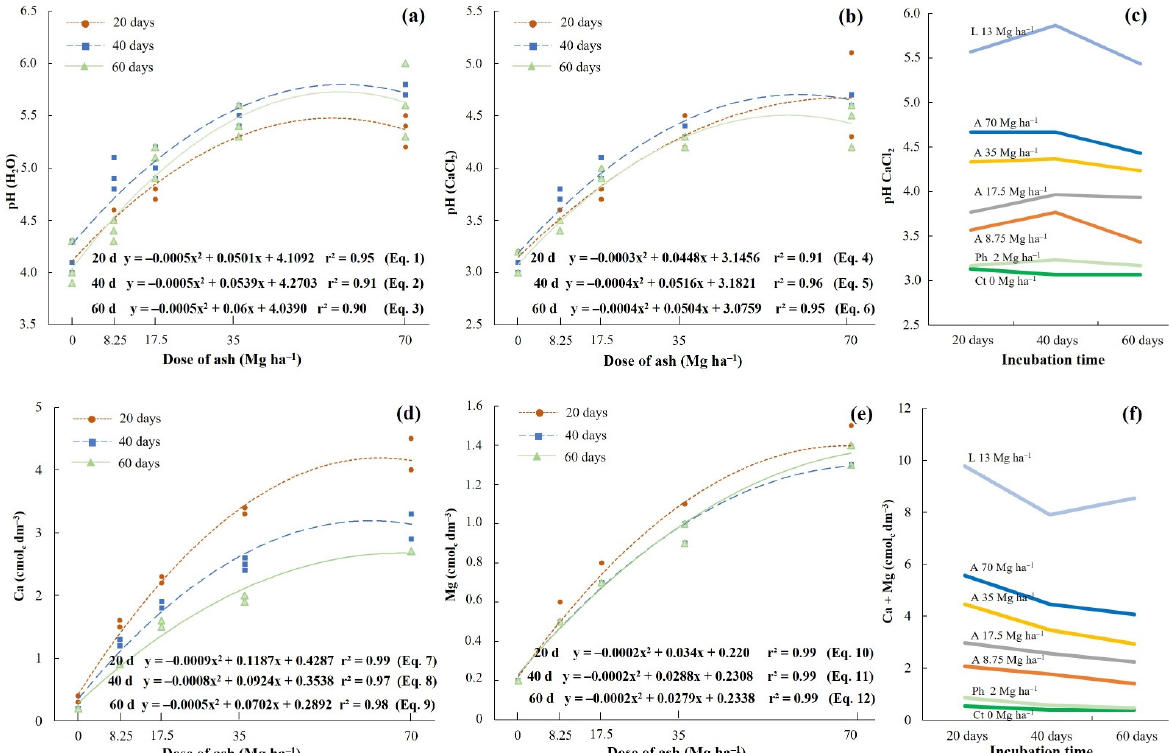
Figure 3. Chemical attributes of the Yellow Latosol after the three incubation times: pH in H 2 O ( a ), pH in CaCl 2 ( b ), and extractable Ca ( d ) and Mg ( e ) levels as a function of ash doses; evolution of pH CaCl 2 ( c ) and Ca + Mg ( f ) contents as a function of the three incubation times in the control soil (Ct) and soil treated with different ash doses (A), lime (L), and phosphate fertilizer (Ph). Even the high-dose ash treatments (35 and 70 Mg ha − 1 ) did not result in pH values or exchangeable cation (Ca 2+ and Mg 2+ ) contents that were significantly similar to those ob- tained in the lime treatment (Table 3 and Figure 3c). However, the treatment with the lowest ash concentration (8.75 Mg ha − 1 ) showed higher pH values than those obtained in pH values obtained with the application of lime are due to its high total neutralizing value (92.4%) and relatively high concentrations of Ca and Mg carbonates. In contrast, biomass ash and phosphate fertilizer have low total neutralizing values (20.5% and 6.7%, respec- tively) and lower carbonate concentrations.